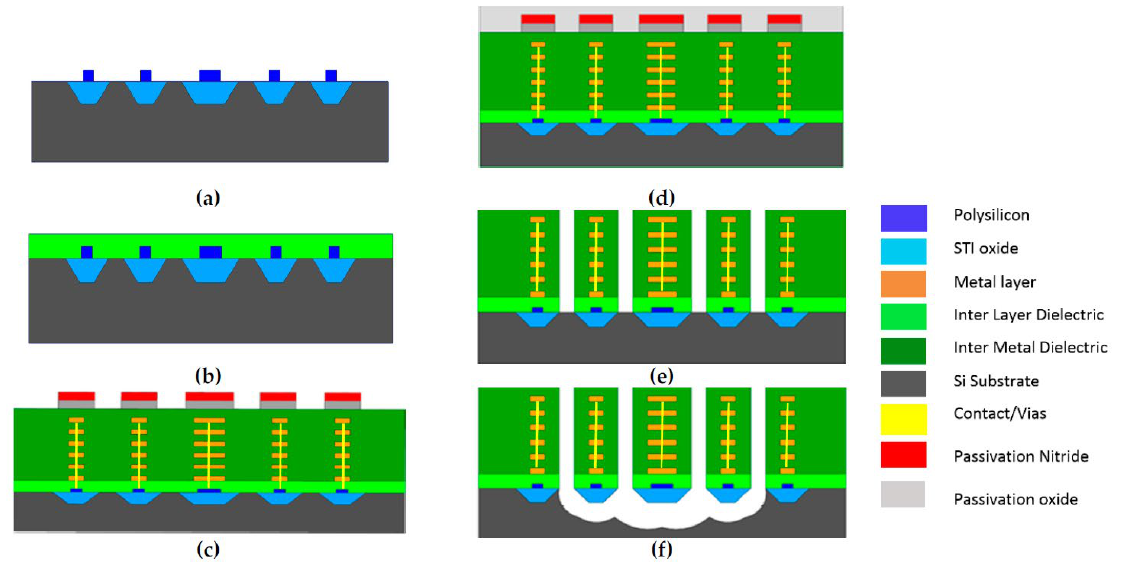
Figure 4. Step-by-step fabrication process of the CMOS MEMS foundry process: ( a ) depositing the polysilicon above the substrate; ( b ) the CMOS layer with additional pattern of contact layer; ( c ) the standard CMOS layer with amorphous SiO 2 , metal M1–M6, metal 7 hard mask and passivation layer; ( d ) depositing the thick photoresist layer to perform the patterning; ( e ) anisotropic silicon oxide etching; ( f ) XeF 2 isotropic silicon etching.